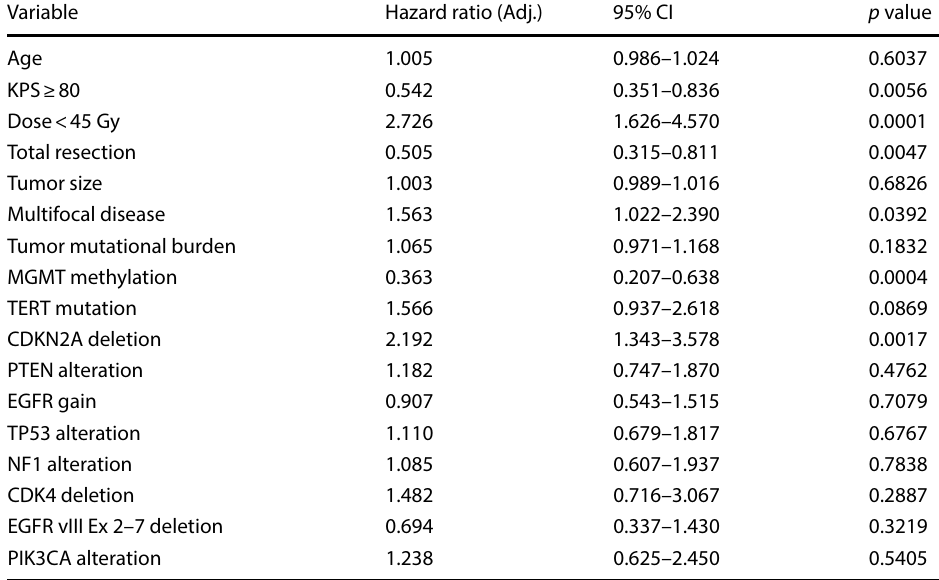
Table 3 Multivariable analysis of impact of patient characteristics, treatments, and tumor genetics on OS in full patient